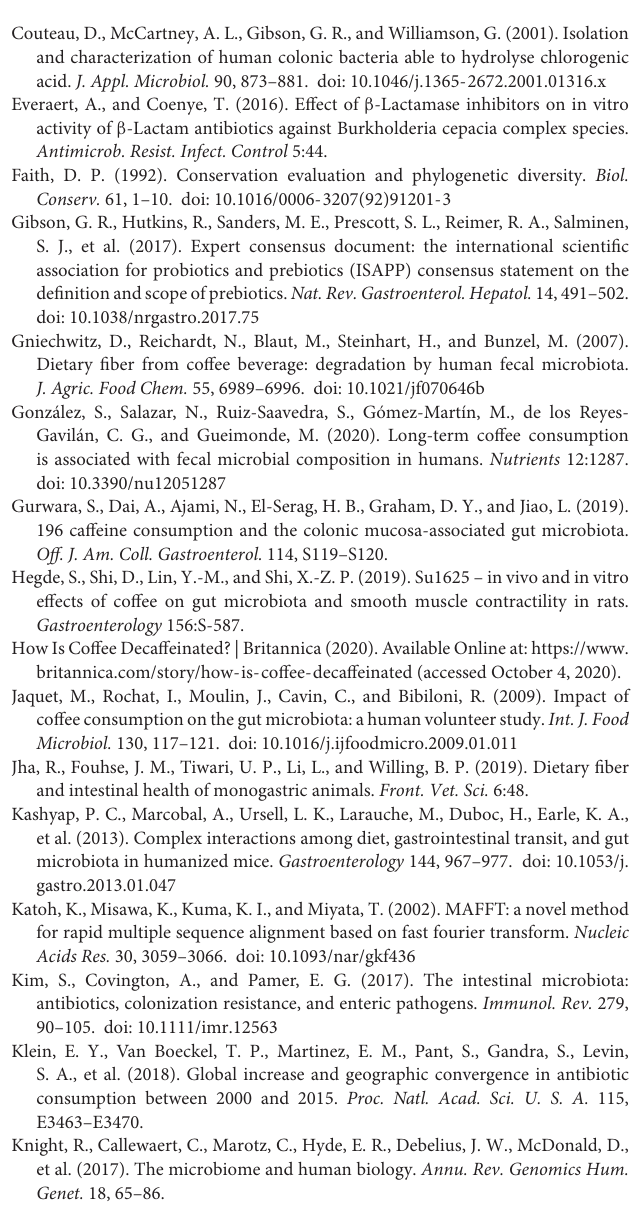
Supplementary Figure 4 | (A–C) Linear discriminant analysis effect size (LEfSe) analysis between antibiotic treated and control groups on day 10 at the family level. Histogram of LDA scores plotted on a log 10 scale. Supplementary Figure 5 | Burkholderiaceae relative abundance, with control and antibiotic samples interleaved by ranked abundance of each taxon. Means represented by dotted (ABX) or dashed (Control) lines. Relative abundance shown for (A) Day 7, (B) Day 10, (C) Day 12. Significance between each group and its antibiotic counterpart is denoted by vertical bars. Solid horizontal bars denote significance between non-antibiotic treated groups (*, 0.01 < P < 0.05; **, 0.001 < P < 0.01; ***, 0.0001 < P < 0.001; ****, P < 0.0001; unpaired t test). Supplementary Figure 6 | (A–C) Linear discriminant analysis effect size (LEfSe) analysis between antibiotic treated and control groups on day 12 at the family level. Histogram of LDA scores plotted on a log 10